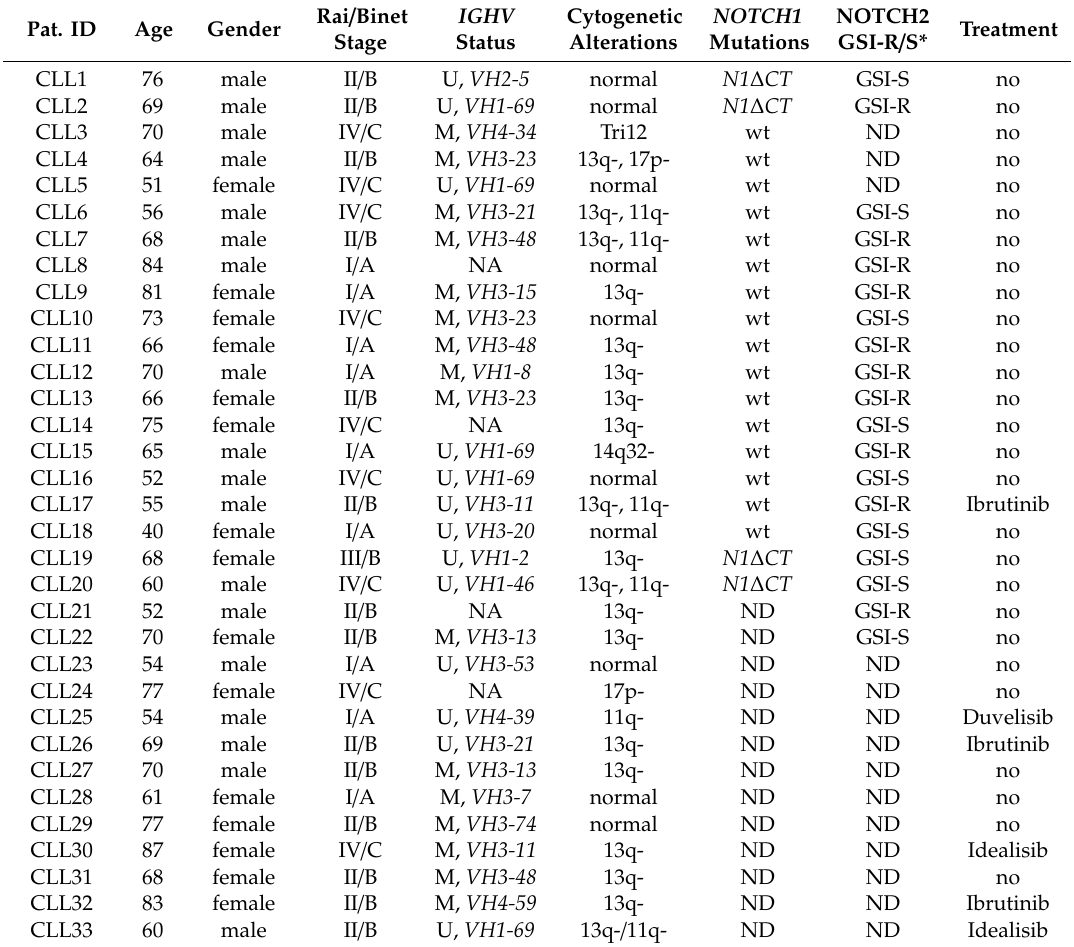
Table 1. Clinical and prognostic parameters of the chronic lymphocytic leukemia (CLL) samples enrolled in this